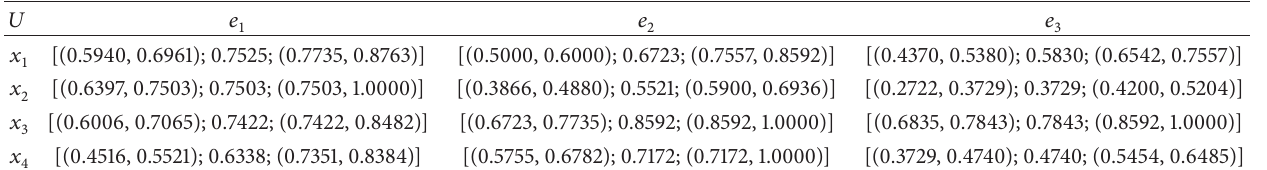
Table 6: Comprehensive interval-valued triangle fuzzy soft